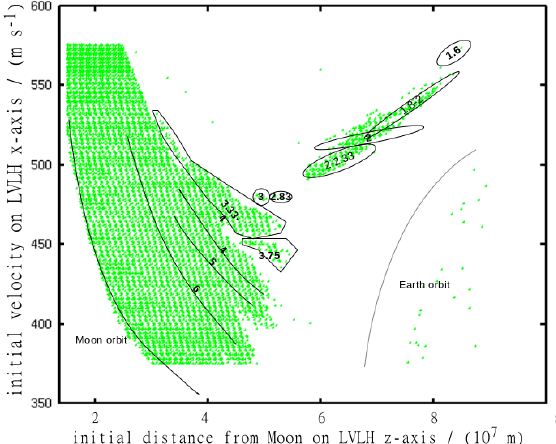
Figure 10. The initial states (shown in green) that remain stable over 30 years. The horizontal axis represents the initial position, measured along the local-vertical-local-horizontal (LVLH) z -axis; the vertical axis represents the initial velocity, directed along the LVLH x -axis. In the lower left, the states are sufficiently slow and close to the moon that they enter a lunar orbit. In the lower right, the vehicle never reaches Lunar orbit and instead enters an Earth quasi-periodic orbit. The numbers in the various regions indicate the approximate resonance ratios (e.g., 1:1:2 = 2; 4:11:15 = 3.75), as determined by investigation of orbital characteristics in these